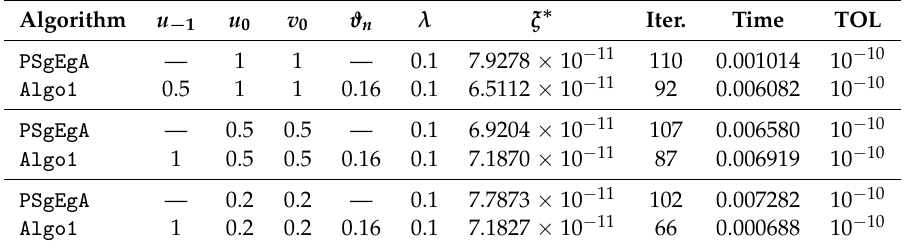
Table 7. Experiment in Section 6.2.2: Algorithm 1 comparison with Algorithm 3.1 in